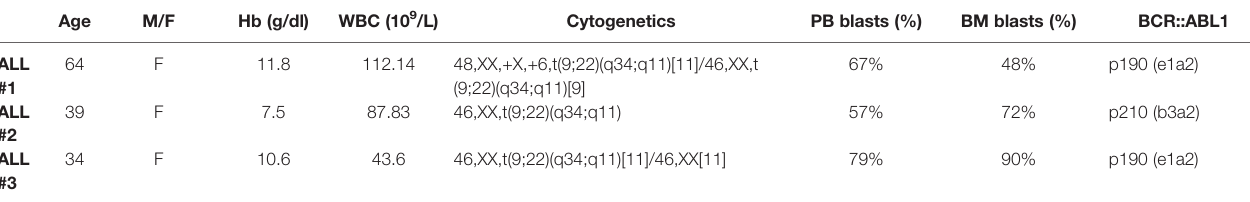
TABLE 2 | Characteristics of the acute lymphoblastic leukemia patients.